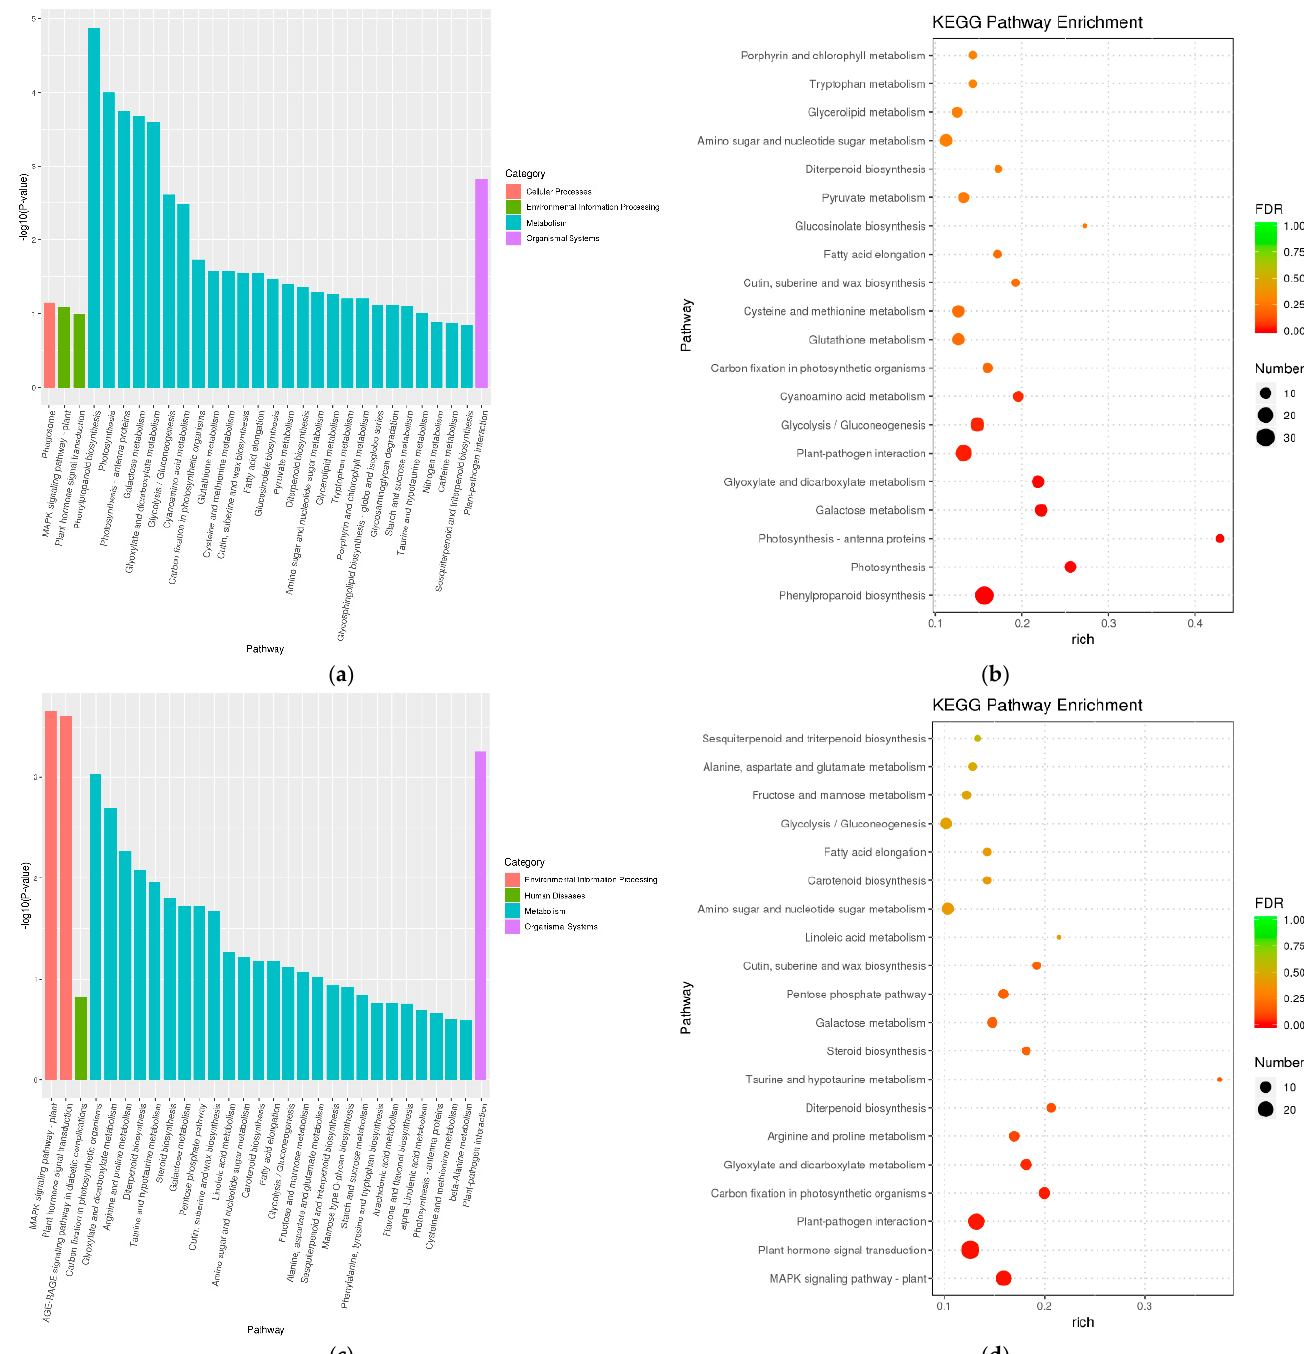
Figure 6. Changes in Kyoto Encyclopedia of Genes and Genomes (KEGG) enrichment pathway in fruits of two late-ripening sweet oranges, LW ( a , b ) and XC ( c , d ) after foliar spraying of easily extractable glomalin-related soil protein (EE-GRSP). Abbreviation: LW_EG, the LW variety sprayed with EE-GRSP; LW_Non_EG, the LW variety not sprayed with EE-GRSP; XC_EG, the XC variety sprayed with EE-GRSP; XC_Non_EG, the XC variety not sprayed with EE-GRSP.